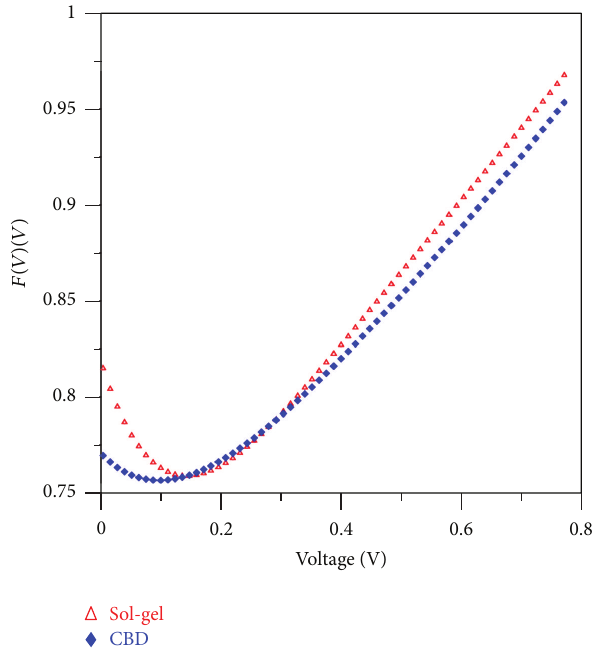
Figure 4: 𝐹(𝑉) versus 𝑉 plots obtained from the experimental 𝐼 - 𝑉 data in Figure